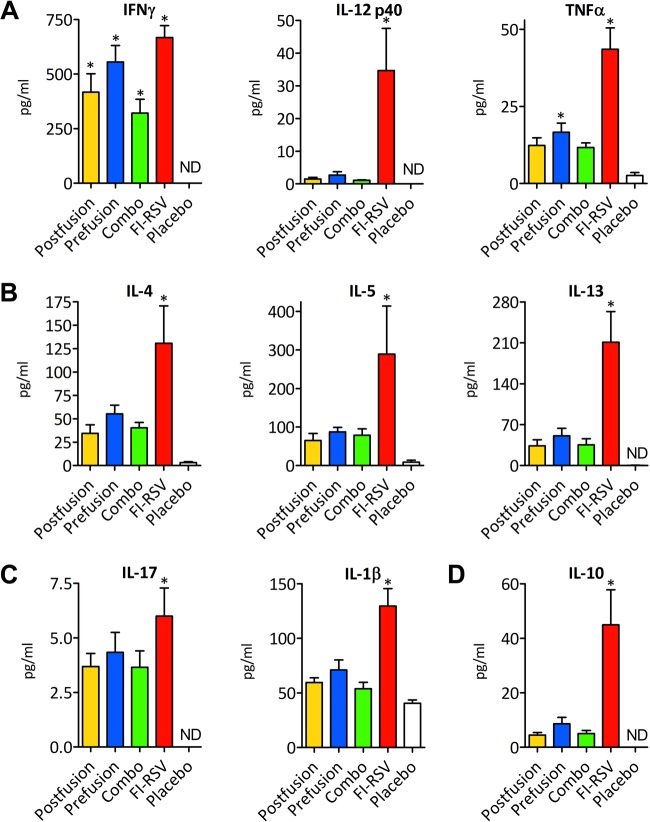
Cytokine responses in VLP-vaccinated mouse lungs after RSV infection. (A) The cytokines for the Th1-mediated response are IFN-γ, IL-12p40, and TNF-α. (B) The Th2-mediated response cytokine measurement includes IL-4, IL-5, and IL-13. (C) The IL-17 and IL-1β analysis indicates the Th17-mediated response. (D) The IL-10 cytokine analysis demonstrates immunoregulatory process development. The results were generated using a group of 4 mice for each condition at 4 days postinfection. An asterisk indicates a statistically significant difference between the experimental condition and the placebo control; differences between the FI-RSV and VLP vaccines were statistically significant (P < 0.05) in all groups, with the exception of the prefusion group in the IFN-γ assay. ND, not detectable.